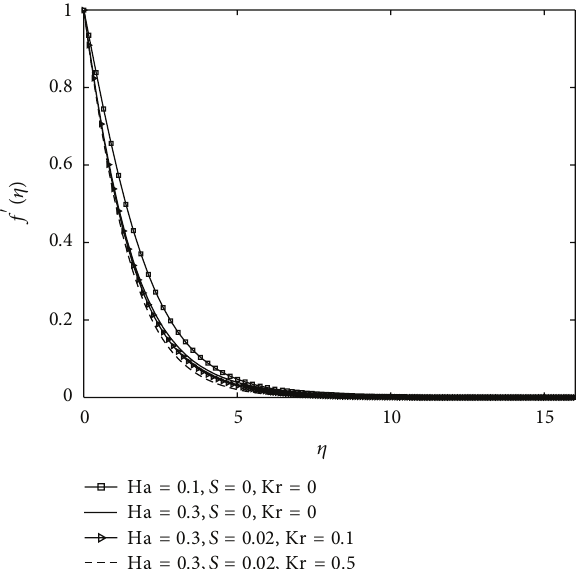
Figure 2: Velocity profiles for different values of Ha, 𝑆 , and Kr for Gr = 0.1 , Gc = 0.1 , Sc = 0.62 , Bi = 0.1 , Nc = 0.01 , and Pr = 0.72